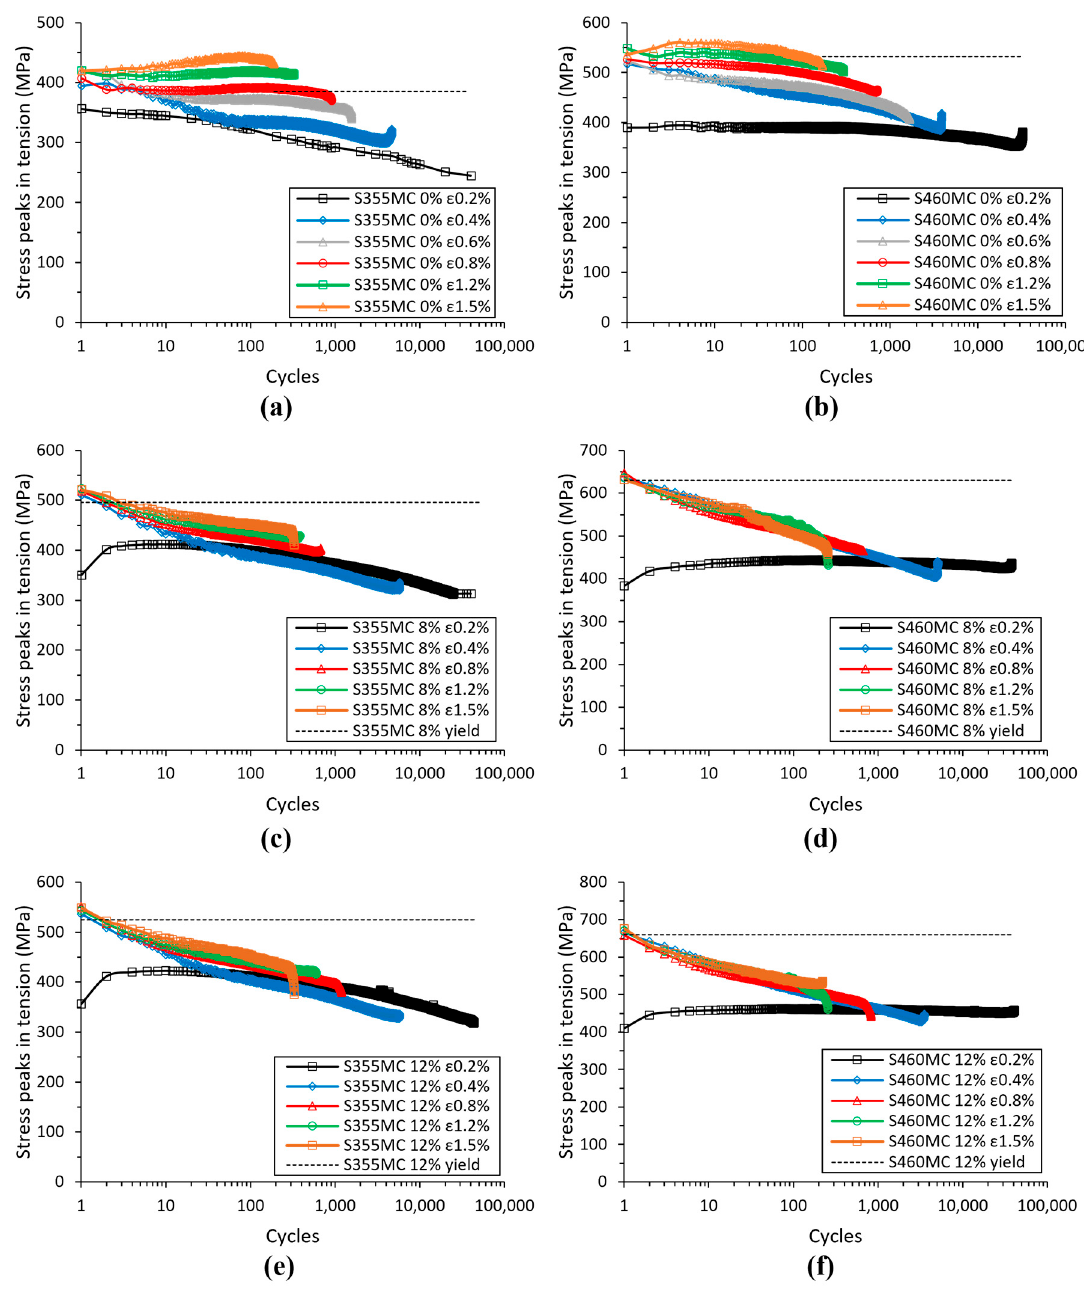
Figure 6. Evolution of cyclic stress peaks under tension with the number of cycles for S355MC steel in ( a ) reference, ( b ) 8% pre-strain, and ( c ) 12% pre-strain material conditions and for S460MC steel in ( d ) reference, ( e ) 8% pre-strain, and ( f ) 12% pre-strain material